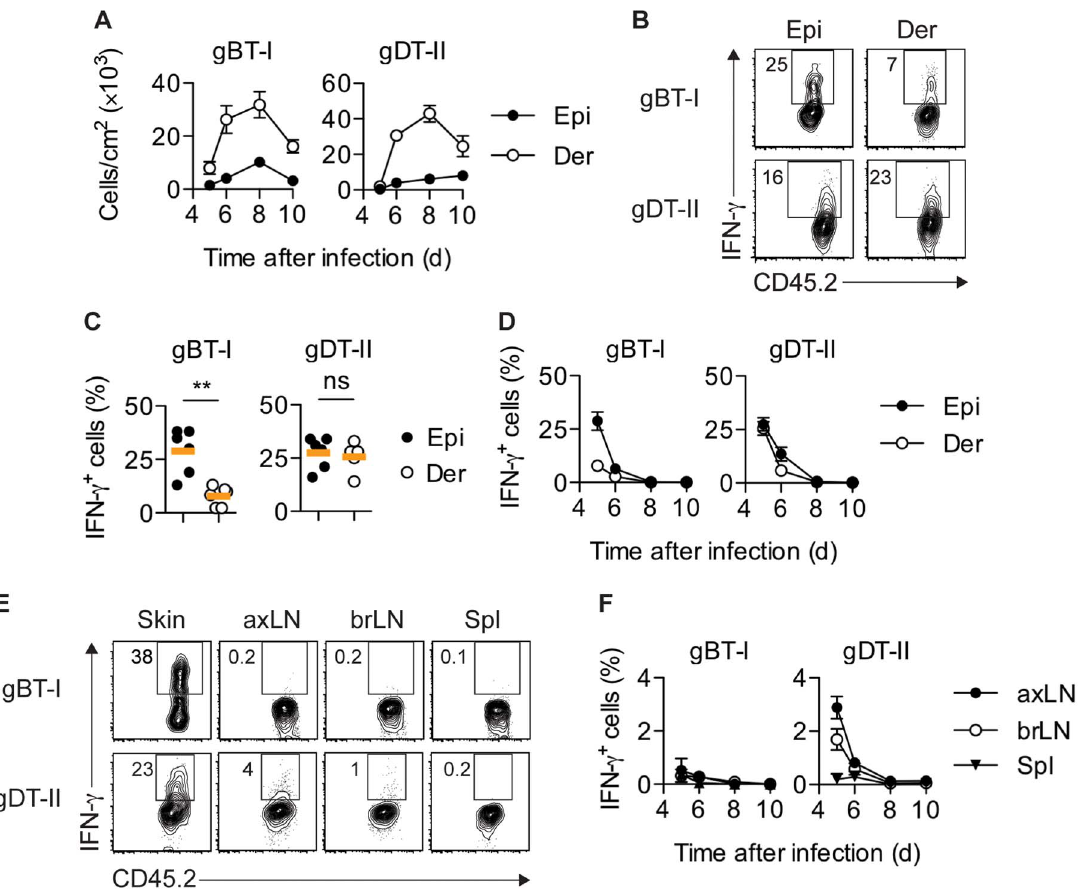
Figure 1. Distribution of IFN- c + T EFF cells. Mice received naı¨ve gBT-I or gDT-II cells prior to HSV-1 skin infection. ( A ) Quantification of T EFF cells in epidermis (Epi) and dermis (Der) 5–10 days post-infection, tracked as CD45.2 + CD45.1 + V a 2 + (gBT-I) or V a 3.2 + (gDT-II) cells (dispase digestion). Data pooled from n =9–14 mice/time point. ( B , C ) Analysis of IFN- c + T EFF cells in skin (dispase digestion) 5 days post-infection. **, P , 0.01; ns, not significant by Mann Whitney test; n =5–6 mice/group from 3–4 experiments. ( D ) Analysis of IFN- c + T EFF cells 5–10 days post-infection; n =4–7 mice/time point from 1–4 experiments. ( E , F ) Analysis of IFN- c + T EFF cells in skin (gBT-I, epidermis; gDT-II, total skin), brachial (brLN) and axillary (axLN) LNs and spleen (5 days post-infection in E , or as indicated in F ); n =2–7 mice/organ/time point from 1–4